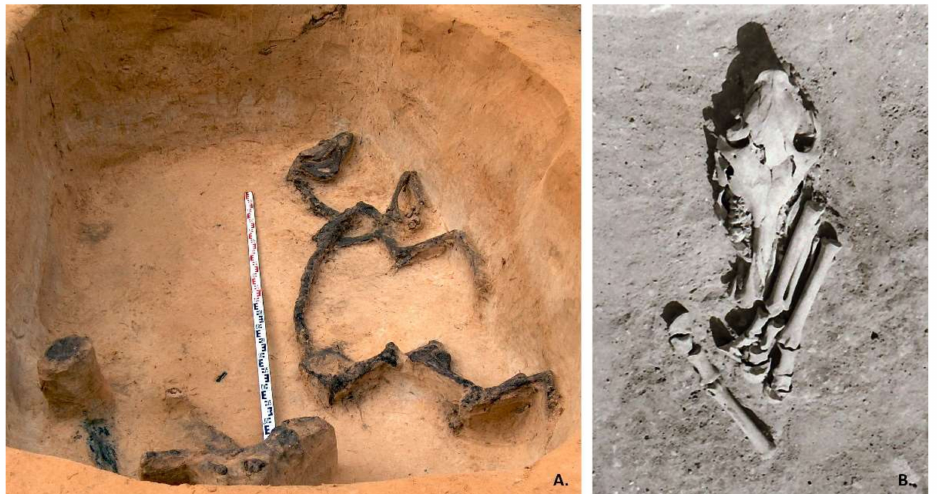
Figure 2. Human and horse burial in Paduob˙e-Šaltali¯un˙e III, photo by V. Steponaitis, 2006 ( A ); horse sacrifice in burial 207 in Pagrybis ( B ), photo by L. Vaitkunskien˙e, 1982, Archive of Lithuanian Institute of History, No.